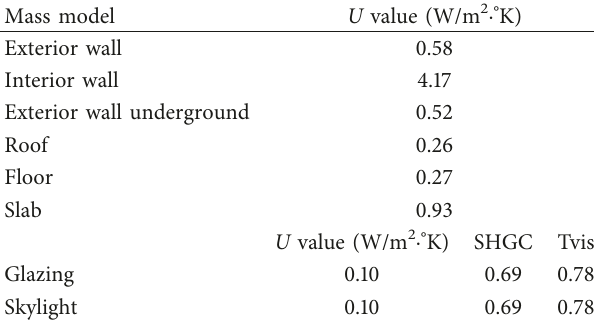
Table 3: Predetermined values of the energy model.